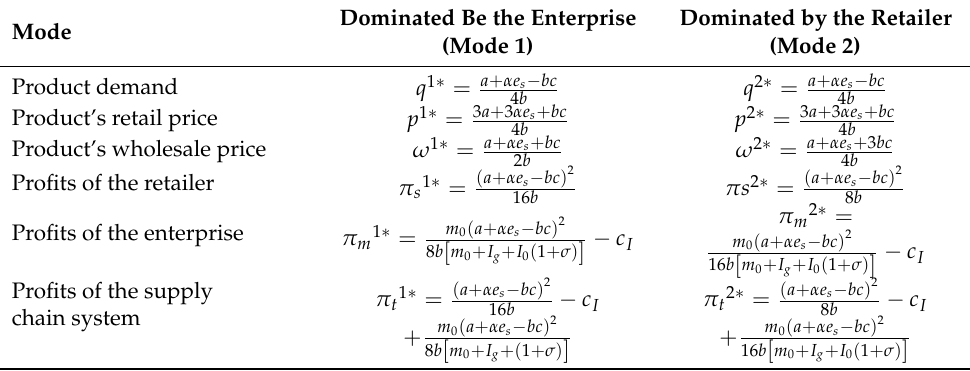
Table 2. Equilibrium